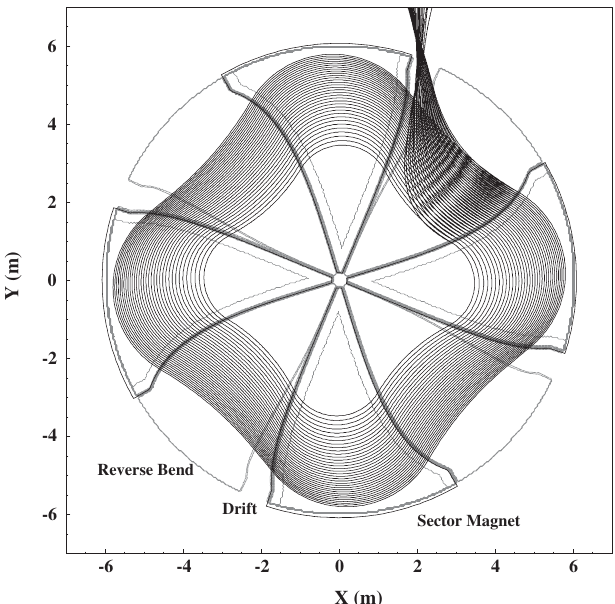
FIG. 5. Magnetic field contours of a H þ 2 cyclotron for proton therapy with reverse bends and drifts. The equilibrium orbits and stripped proton trajectories for energies from 70 to 250 MeV in steps of (cid:5) 5 : 5 MeV are plotted on top.